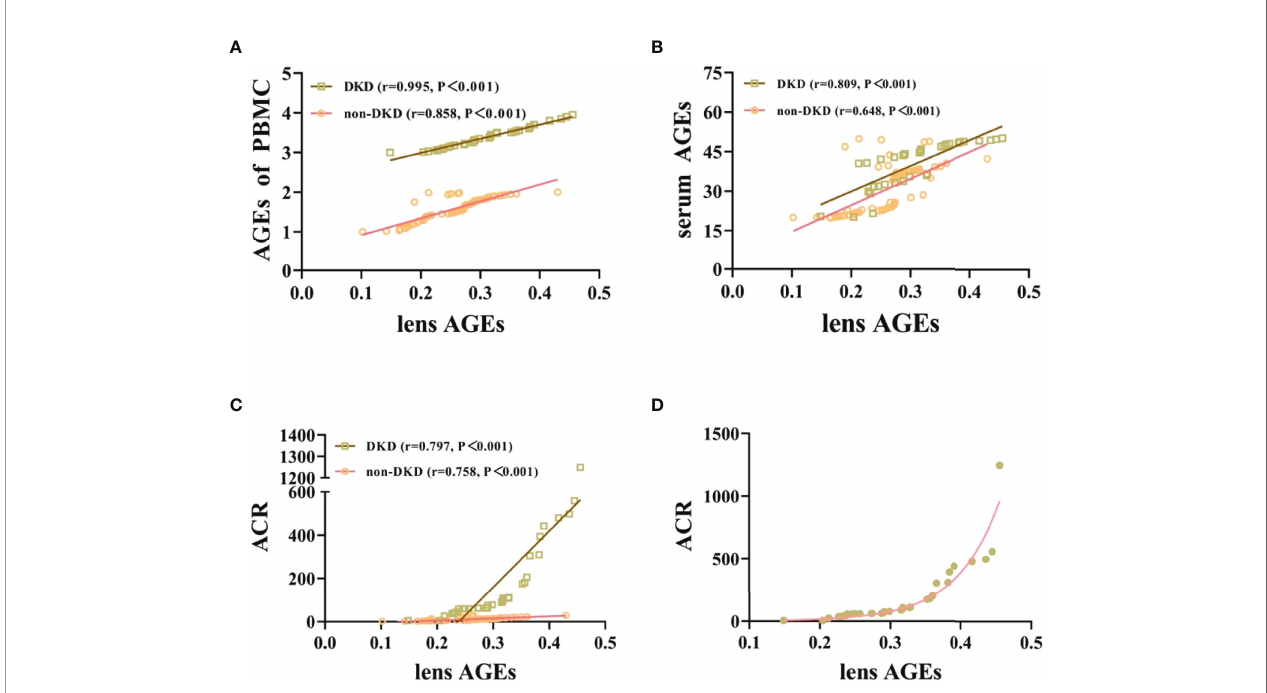
FIGURE 2 | Lens AGEs in patients with T2DM were positively correlated with PBMCs and serum AGEs and urinary ACR. (A) Correlation analysis of lens AGEs and PBMC AGEs in patients with T2DM (400x). (B) Correlation analysis of lens AGEs and serum AGEs in patients with T2DM. (C) Correlation analysis of lens AGEs and urinary ACR in patients with T2DM. (D) In the DKD group, the detection value of lens AGEs gradually increased with increasing urinary